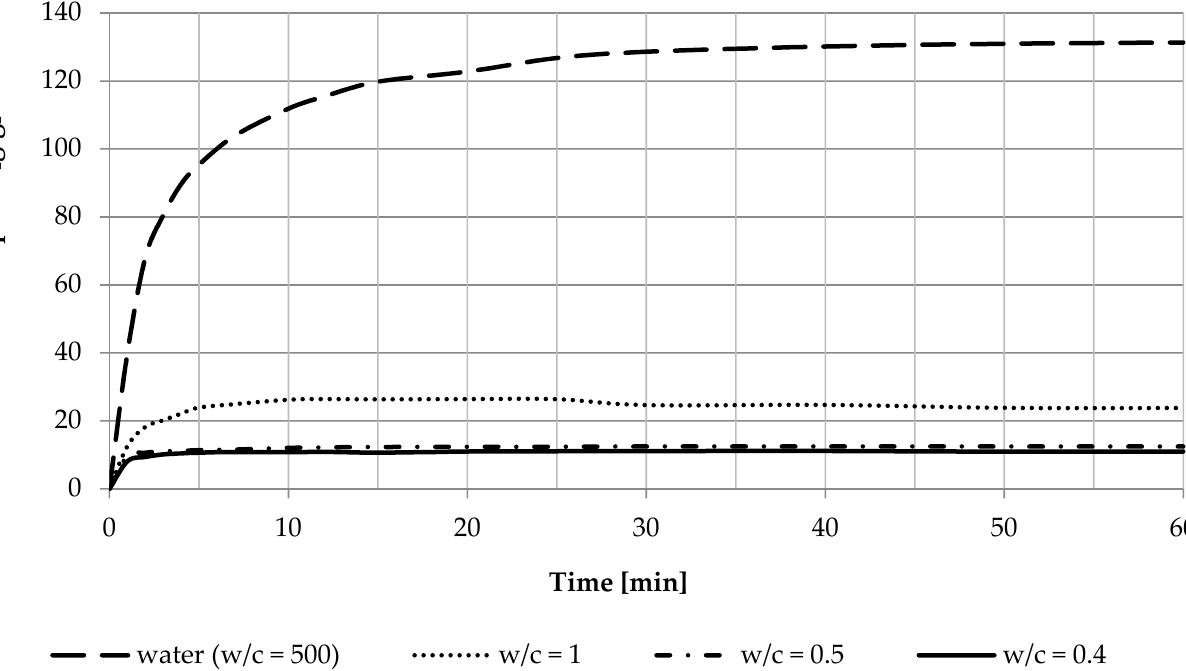
Figure 4. Water absorption capacity as a function of time in water absorption environments of different water-to-cement ratios.